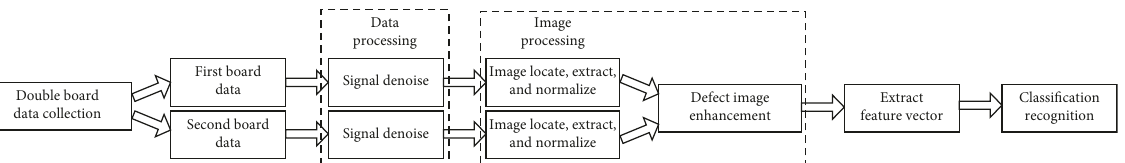
Figure 4: Defect recognition flow chart.